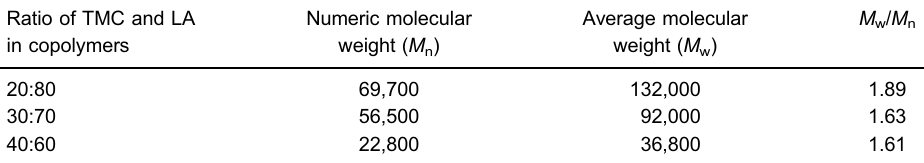
Table 2. Molecular weight of poly(trimethylene carbonate- co -L-lactide) copolymers. Ratio of TMC and LA